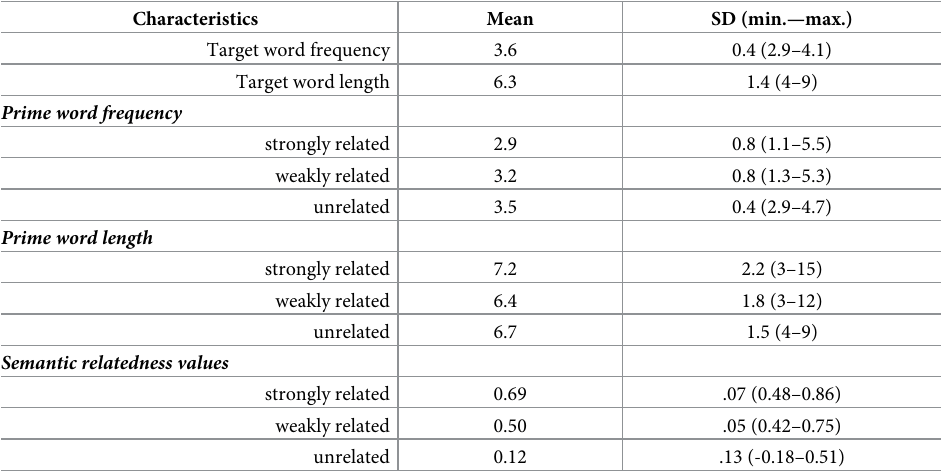
Table 4. Prime and target word characteristics of 216 word pair triplets: Length, word frequency (Zipf values), and the semantic relatedness values (cosine similarity scores) for the strongly related, weakly related, and unre- lated conditions tested in Experiment